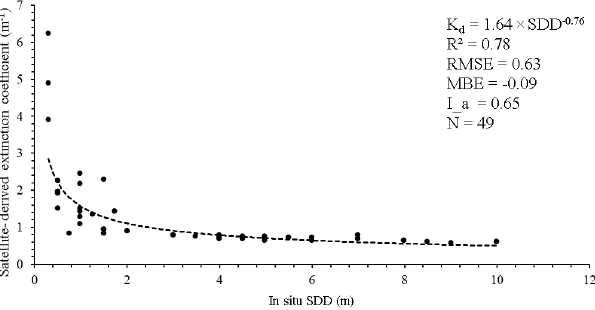
Figure 3. Relation between satellite-derived K d and in situ SDD